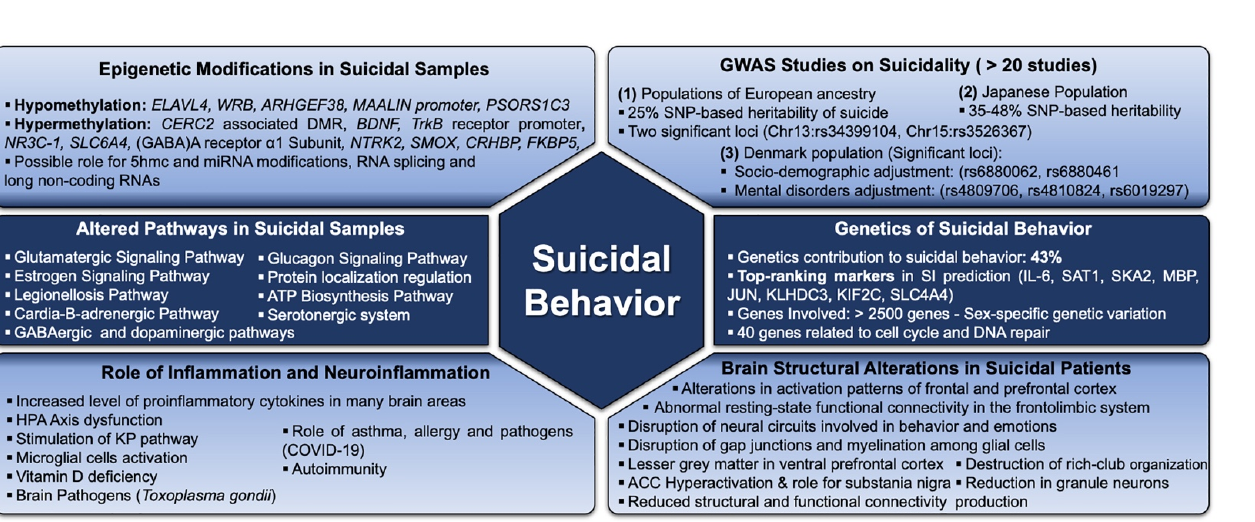
Figure 1. General summary of the genetic and neurobiological factors underlying suicidal behaviour. (Created in BioRender.com (accessed on 2 April 2022)).